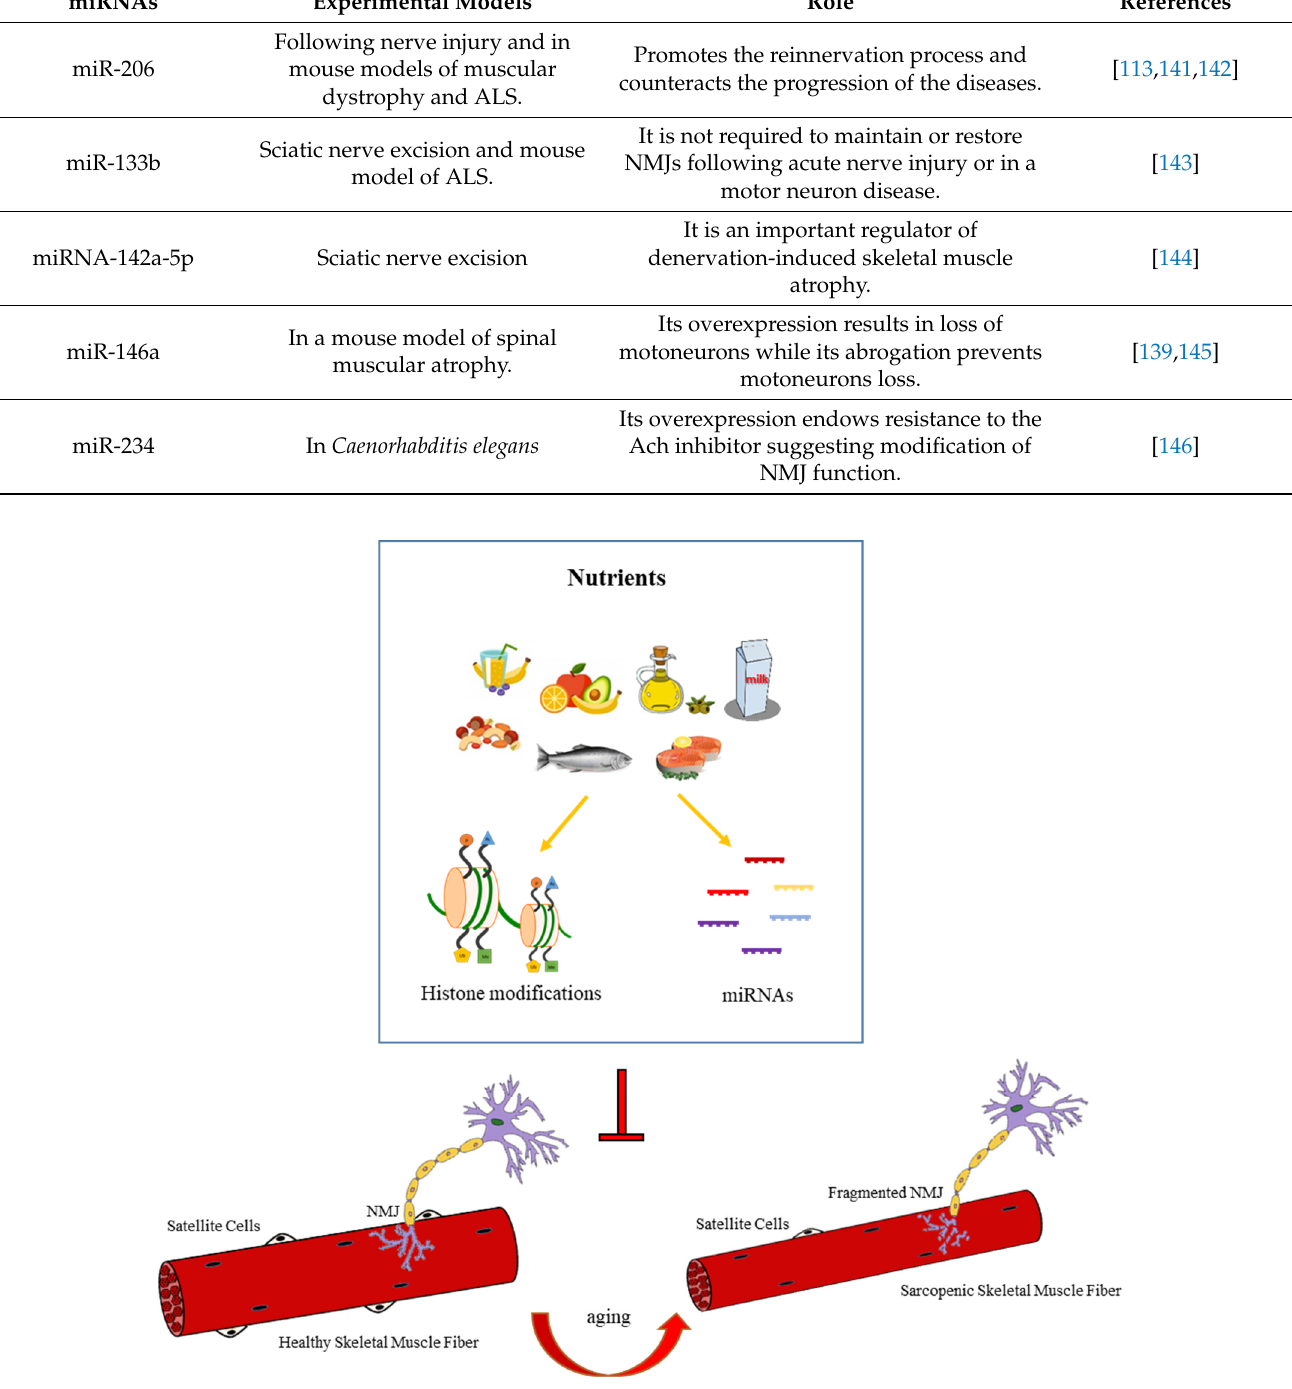
Figure 3. Nutrient-dependent epigenetic modifications involved in NMJ remodeling during aging. Nutrients and diet compounds may affect histone modifications and miRNAs expression, counteracting NMJ dismantlement involved in the onset of